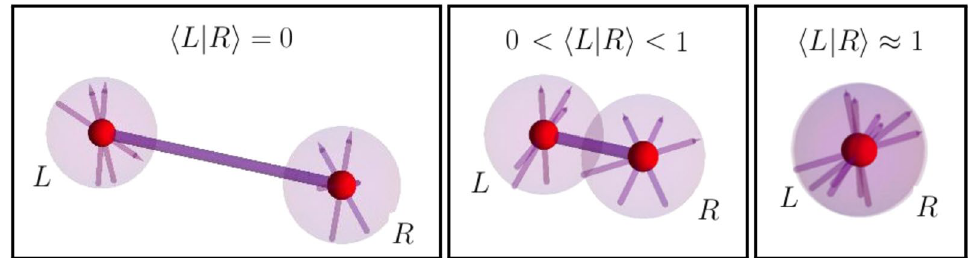
Figure 1. Pictorial representation of two identical particles with an internal degree of freedom and a spatial degree of freedom, when the spatial wave function do not overlap particles), partially overlap 0 <